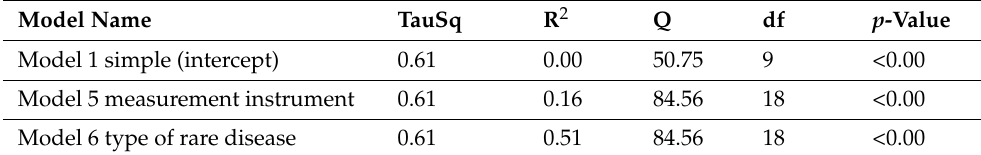
Table 7. Model comparison: Random effects (MM), Z-distribution, Fisher’s Z.